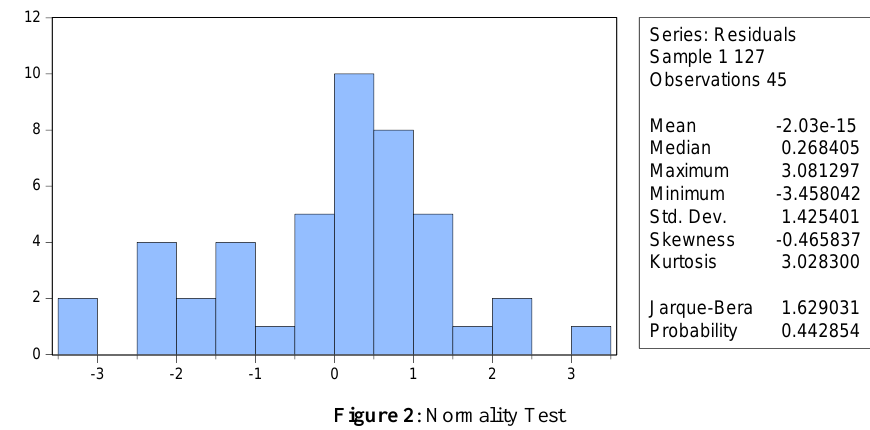
Figure 2 : Normality Test